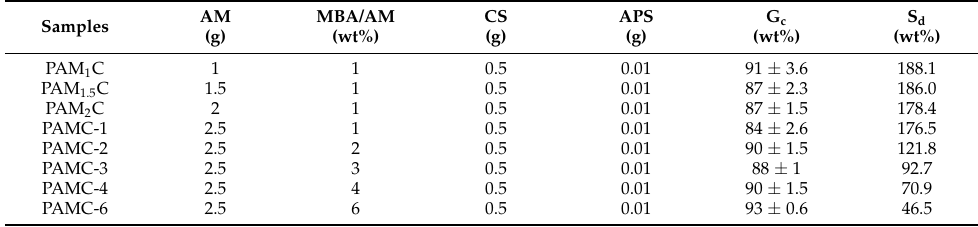
Table 1. Specific ratios and properties of PAMC hydrogel.